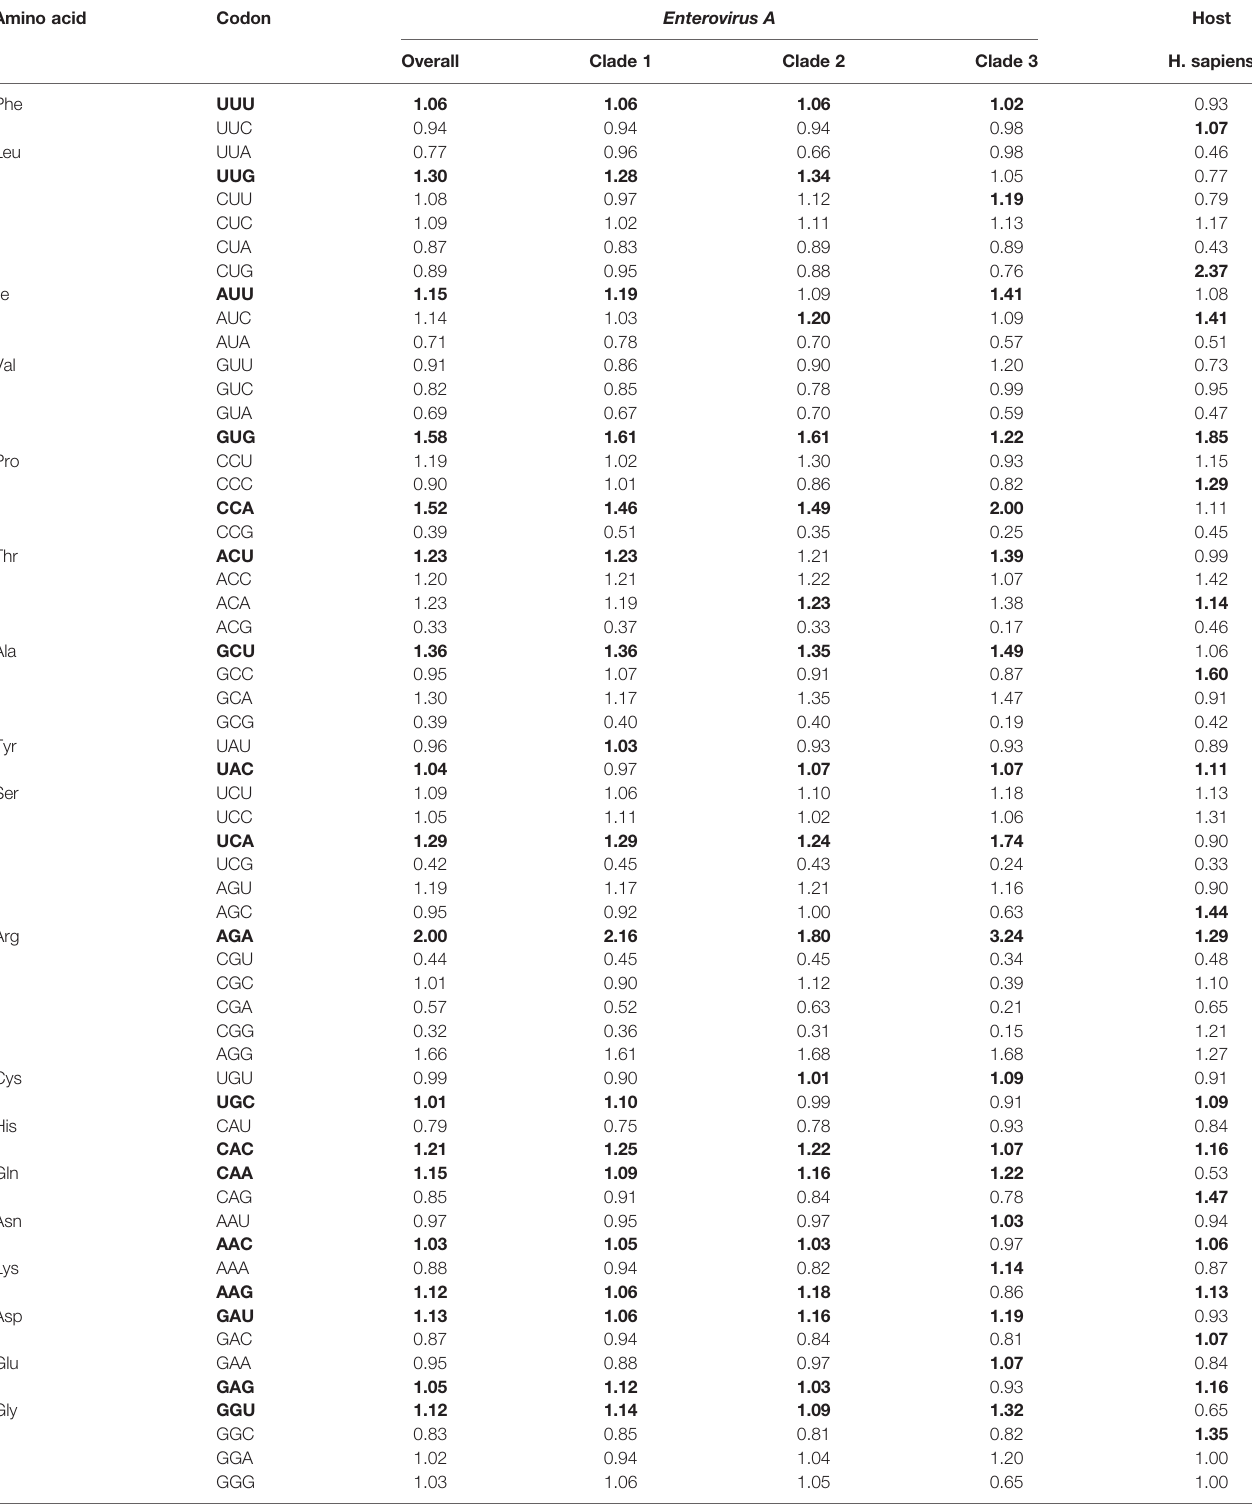
TABLE 1 | The relative synonymous codon usage (RSCU) patterns of Enterovirus A. Amino acid Codon